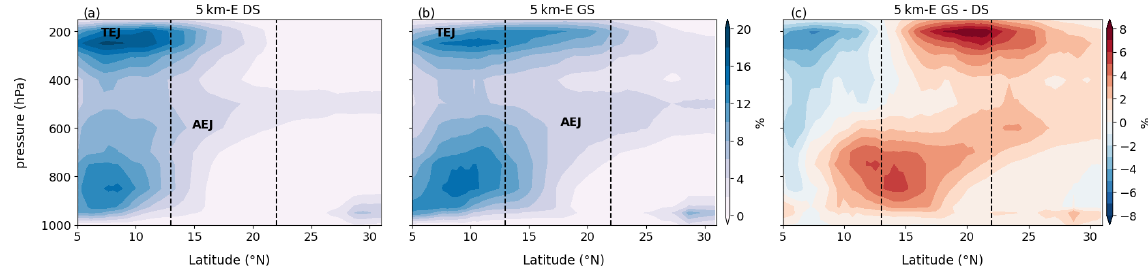
Figure A2. JAS mean cloud cover over the WA domain for the 5km-E DS simulation (a) , the GS simulation (b) , and the difference between GS and DS (c) . The vertical black dashed lines indicate the borders of the coastal, the Sahel, and the Sahara region outlined in Fig. 2.